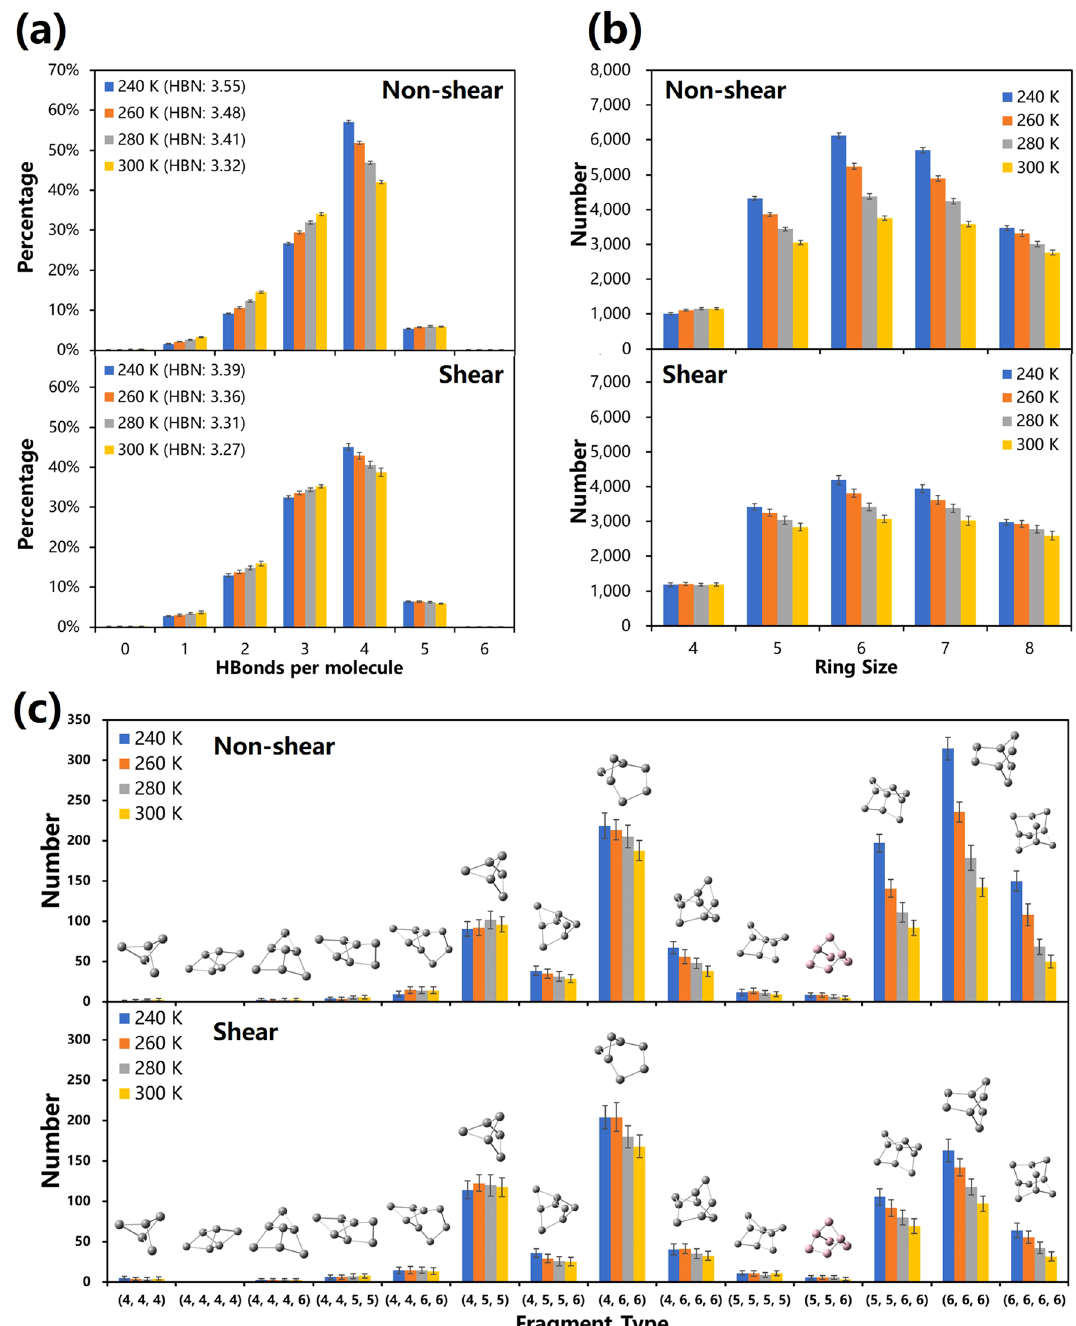
Figure 3. The distribution of hierarchical structures at the 1st, 2nd and 3rd levels in the network in various cases. ( a ) The distribution of hydrogen bonds (1st-level structures) at various temperatures. ( b ) The distribution of rings (2nd-level structures) at various temperatures. ( c ) The distribution of fragments (3rd-level structures) at various temperatures. Note that (4, 4, 4) denotes a symbol of a fragment including three 4-membered rings. The structures are drawn by GaussView 5.0.8 50